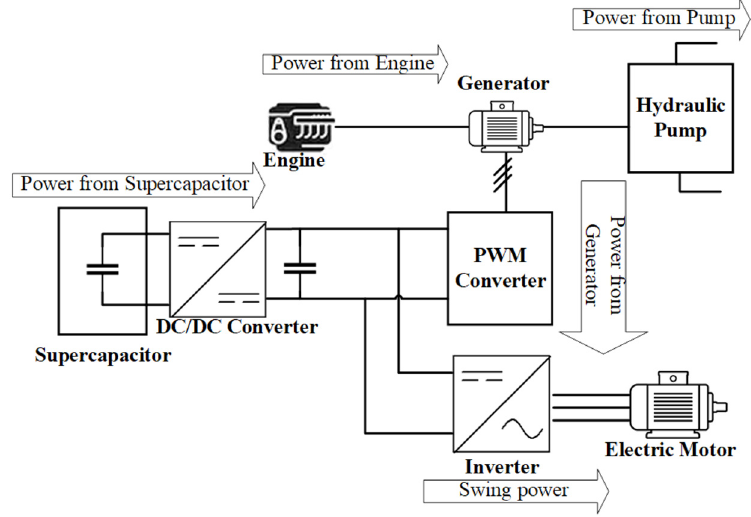
Figure 5. Configuration of compound hybrid excavator [20]. The supercapacitor is used as the electrical energy storage system while the electric drivetrain runs the swing electric motor with engine assistance.